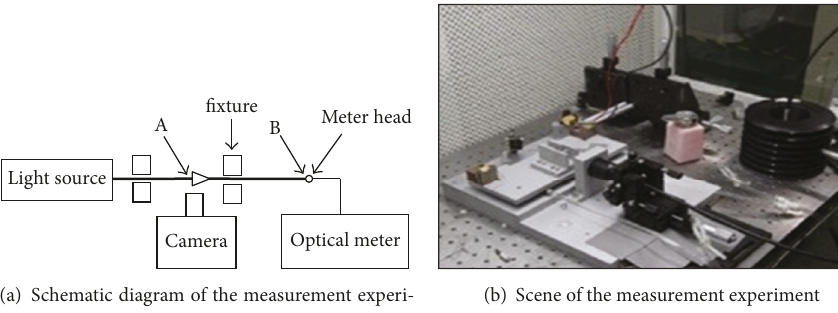
Figure 6: The experiment scene of coupling efficiency measurement.